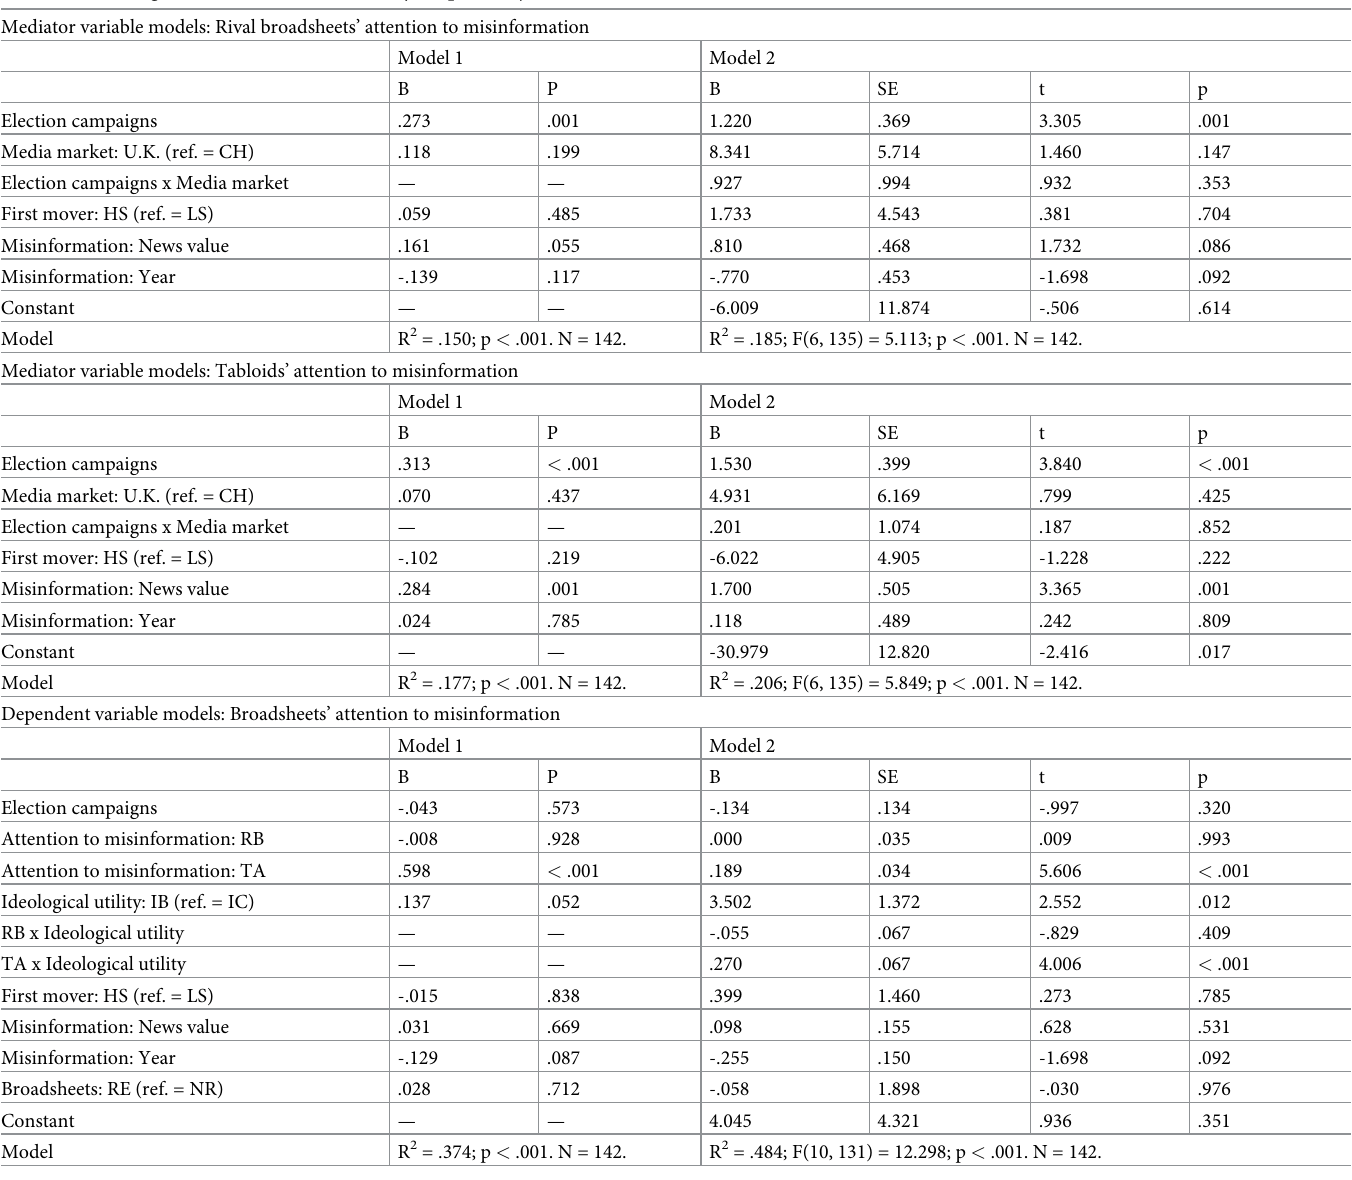
Table 5. Linear regressions and moderation analyses (political